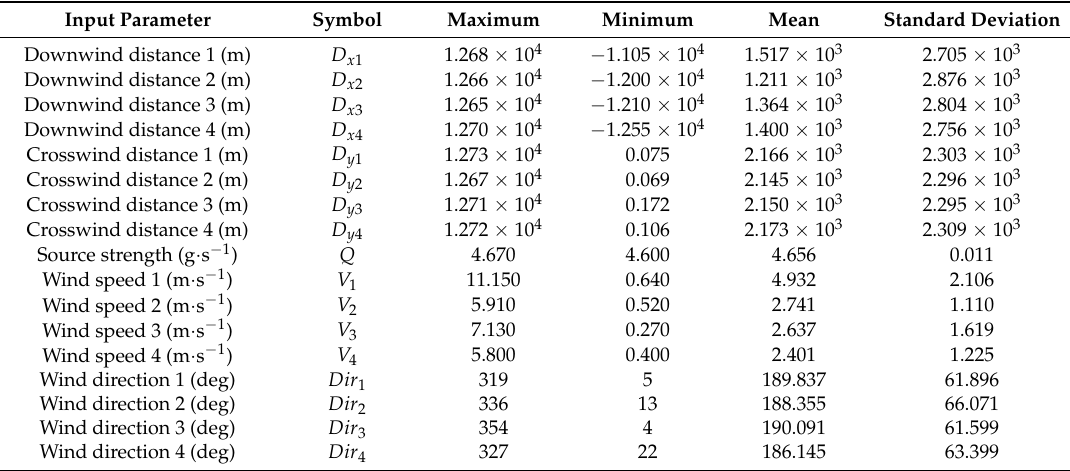
Table A2. The statistical indicators of the inputs in the Indianapolis